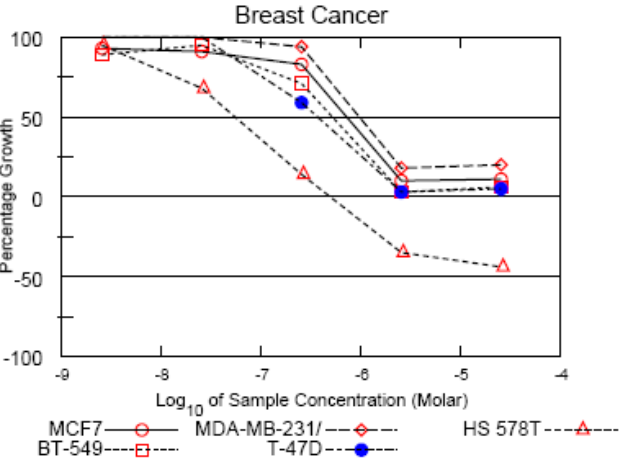
Figure 3. The effect of the 3c compound on the HS 578T breast cancer cell line, with a growth present of − 44.